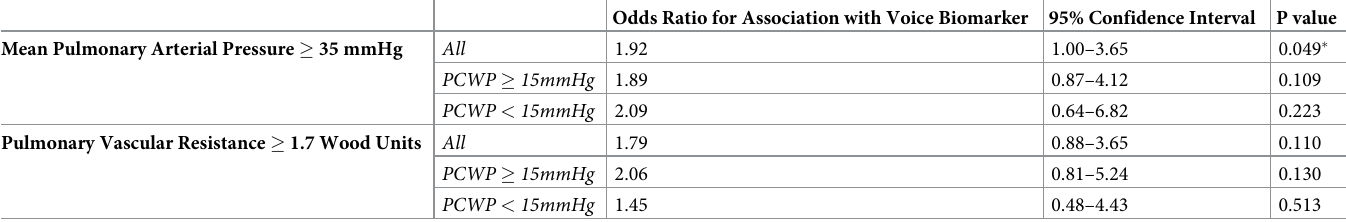
Table 2. Univariate analyses evaluating the association between mean voice biomarker and hemodynamic indices measured at invasive hemodynamic study. Odds Ratio for Association with Voice Biomarker 95% Confidence Interval P